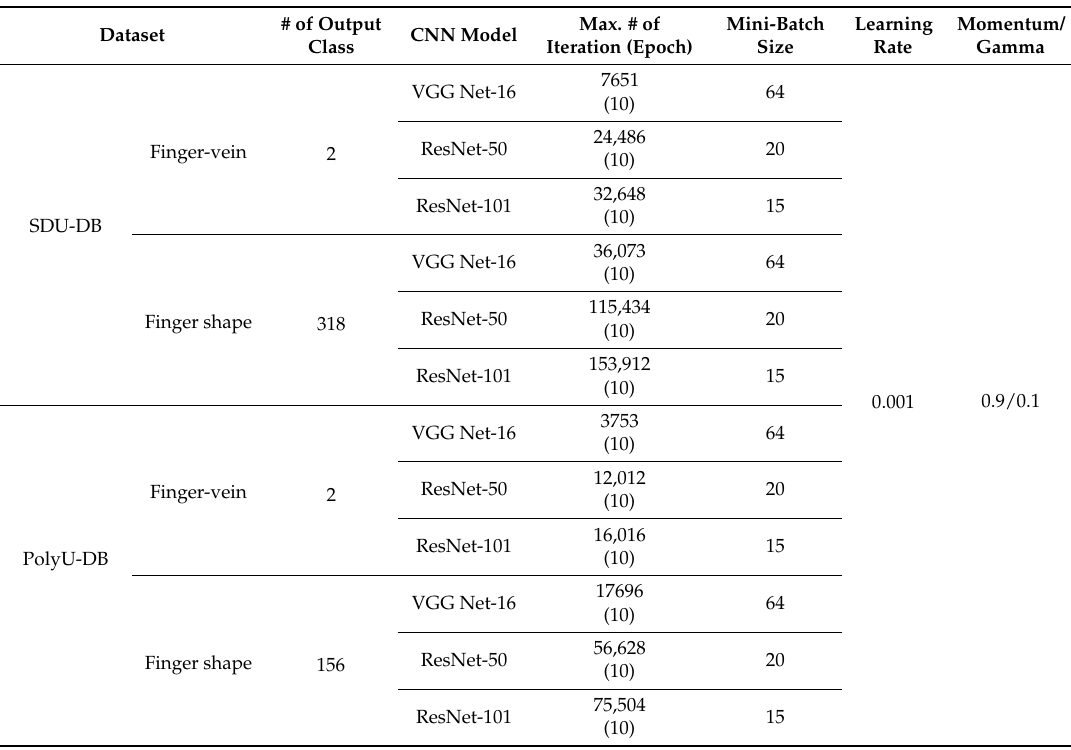
( d ) Figure 8. Examples of loss and accuracy curves with training data of two-fold cross validation according to databases. Using ( a ) finger-vein images in SDU-DB database, ( b ) finger shape images in SDU-DB database, ( c ) finger-vein images in PolyU-DB database, and ( d ) finger shape images in PolyU-DB database. In ( a )–( d ), the left and right figures show the results of the first and second cross validation, respectively. Table 4. Descriptions of initial parameters for training of various CNN models (“# of” represents “the number of”).